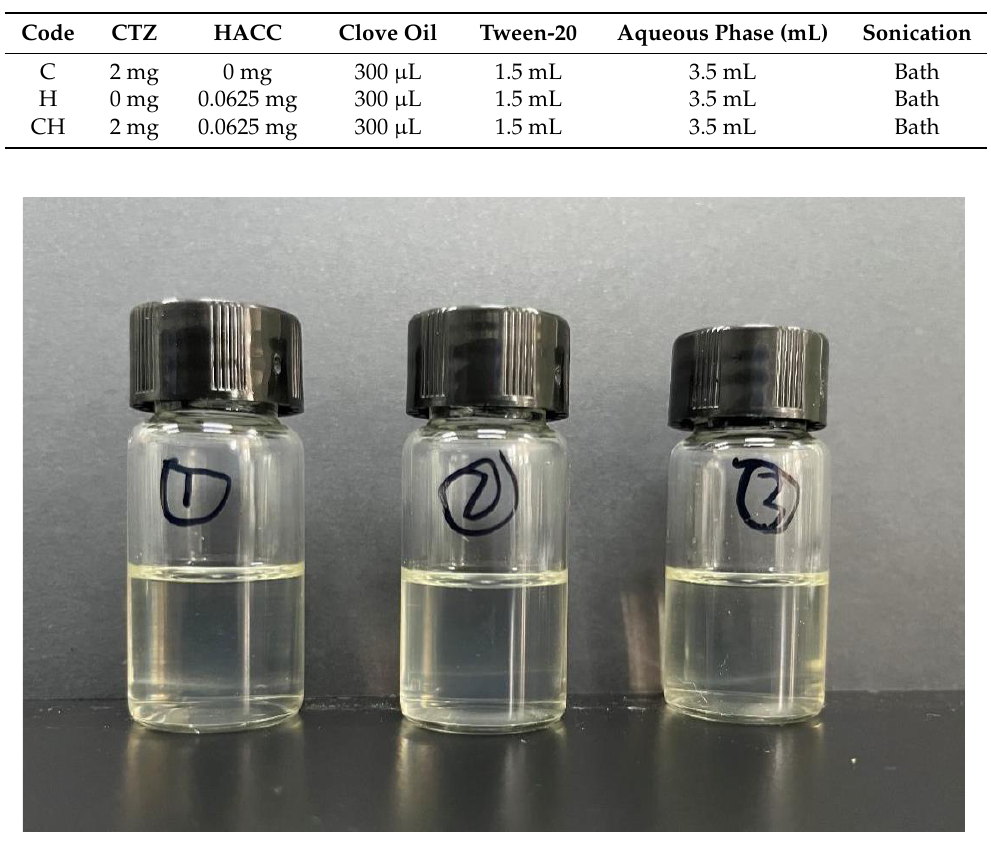
Figure 2. Three sets of microemulsions after optimization. Labels 1, 2, and 3 represent C, H, and CH,